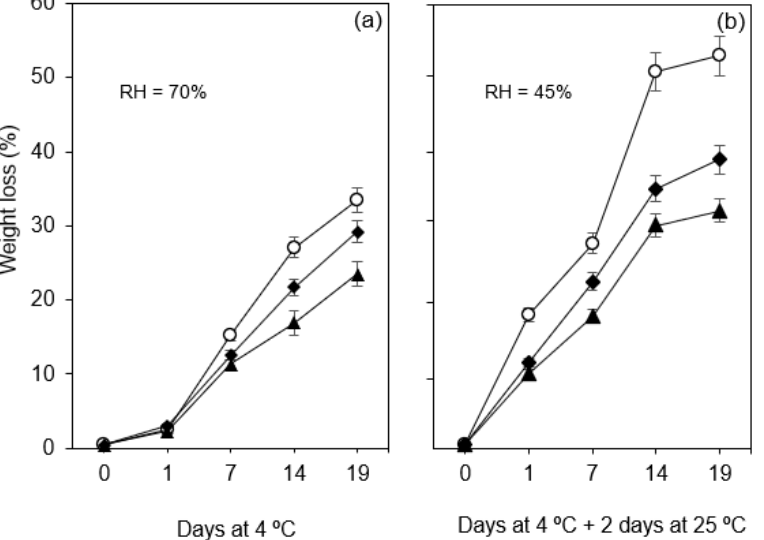
Figure 4. Weight loss of fresh figs ( Ficus carica L. var. ´Pingo de mel´) coated ( C-OO-TPP and A-OO-Ca) and uncoated ( Ctr), under refrigeration for over 19 days at 4 °C ( a ) and after being transferred to room temperature for 2 days ( b ). RH: Relative humidity.